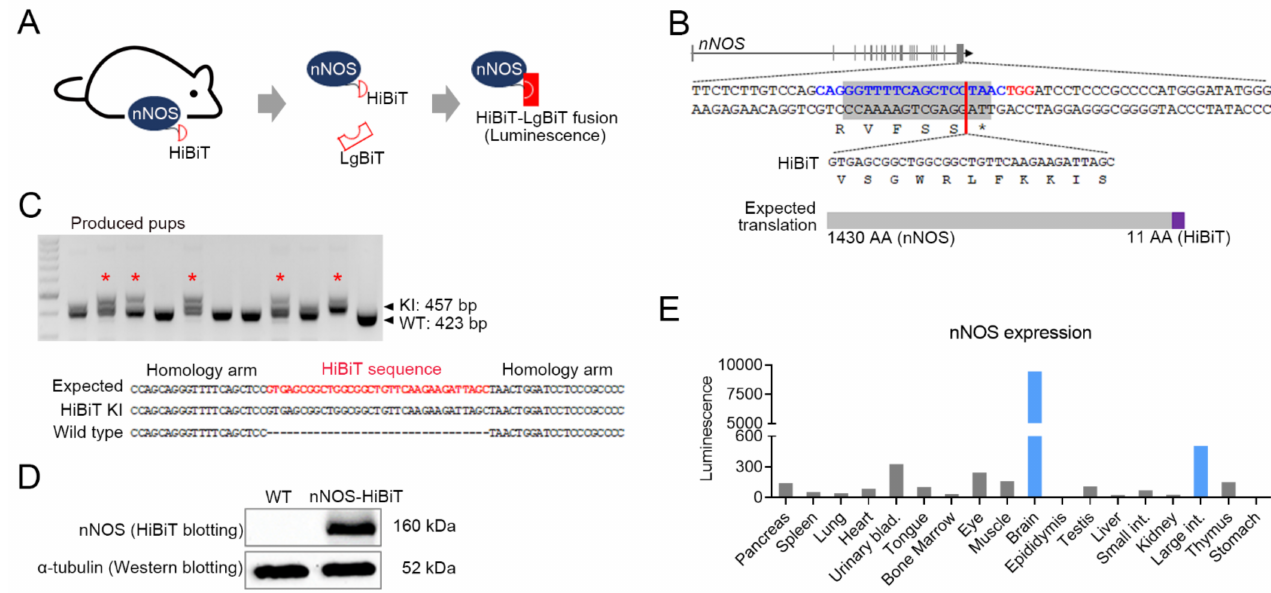
Figure 1. Generation of an nNOS-HiBiT knock-in (KI) mouse and evaluation of HiBiT analysis. ( A ) Brief schematic of nNOS-HiBiT fusion protein for luminescence detection. ( B ) Single guide RNA was designed for 33-base pair of HiBiT sequence KI upstream of the stop codon in the nNOS gene. Blue alphabets: sgRNA binding sequence, Red alphabets: protospacer adjacent motif sequence. ( C ) PCR and Sanger-based genotyping was conducted for obtained pups. Red symbol: KI expected pups, Red alphabet: an expected correct sequence of HiBiT. ( D ) neuronal nitric oxide synthase (nNOS) protein was detected by HiBiT blotting using the nNOS-HiBiT KI and wild type. Western blotting for α -tubulin was conducted to confirm protein integrity. ( E ) nNOS expression was measured by HiBiT lytic analysis with 18 different organs from an nNOS-HiBiT KI mouse. Luminescence value was subtracted by background